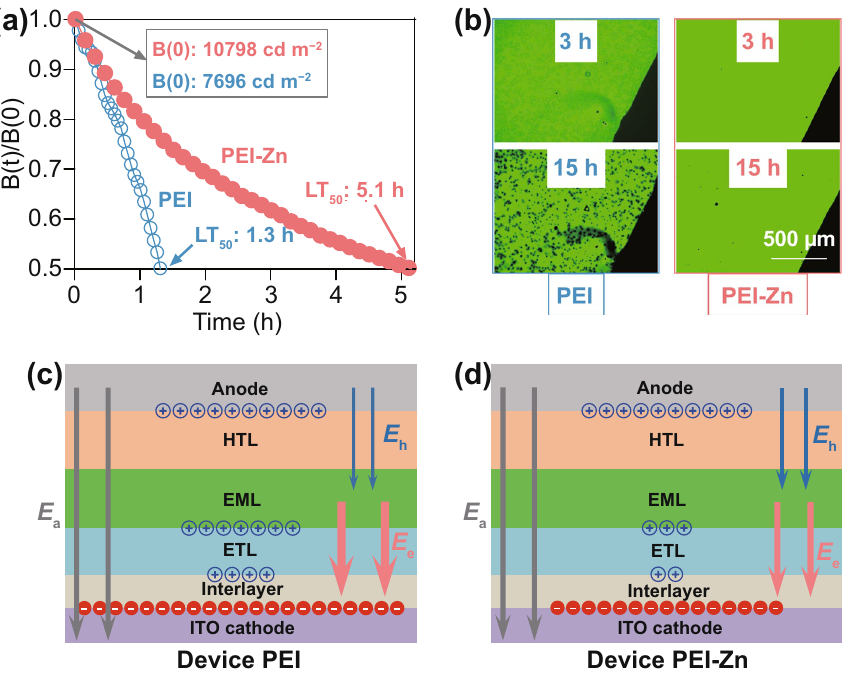
Fig. 5 a Operating lifetimes of device PEI and device PEI‑Zn at a current density of 20 mA cm −2 . b Images of light‑emitting areas of device PEI and device PEI‑Zn after storing for 3 h and 15 h. Schematic mechanism of c device PEI and d device